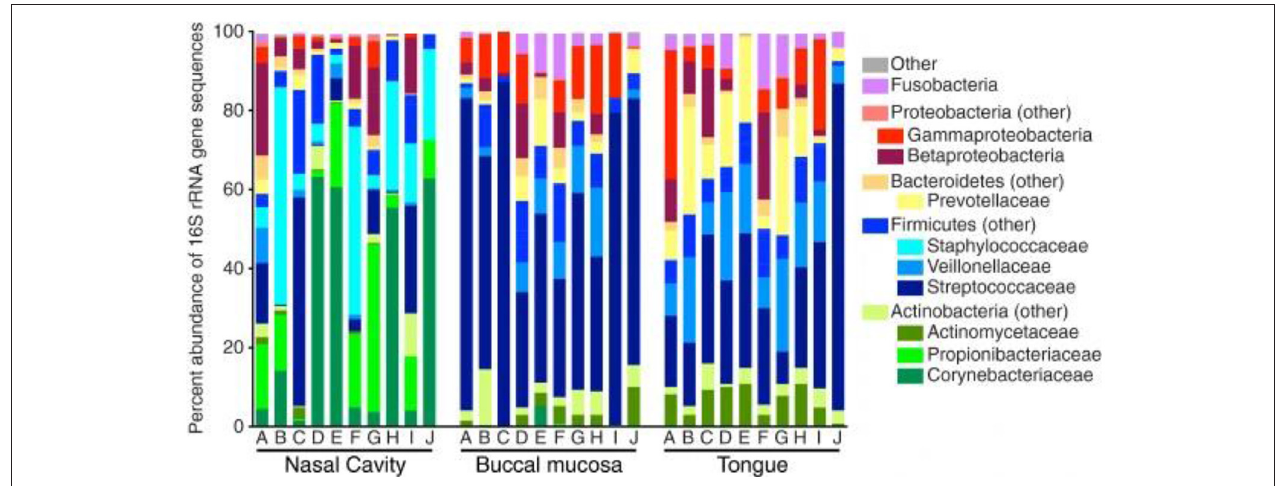
FIGURE 1 | Bacterial composition within the healthy nasal cavity, compared to the buccal mucosa and tongue. Data presented as relative abundances, and each column (marked by letters A through J) represents an independent study participant. Reprinted from ( 22), with permission under the Creative Commons Attribution